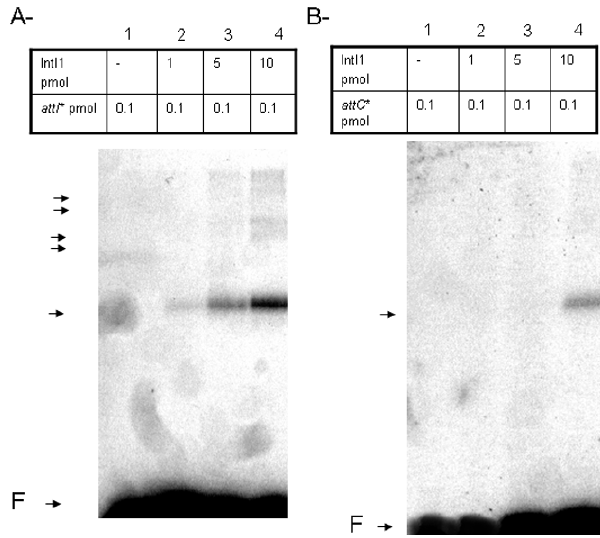
Figure 3. Invitro DNA binding of IntI1 with free double-stranded attI1 (A) and attC (B) recombination sites. Free 5 9 32 P radiolabeled dsDNA fragments containing recombination sites (0.1 pmoles) were incubated with purified IntI1 (1–10 pmoles) at 4 u C for 20 min before electrophoresis on 1% agarose gel run at 50 V, for 2 hours at 4 u C. Arrows indicate the protein-DNA complexes and F corresponds to free recombination sites.